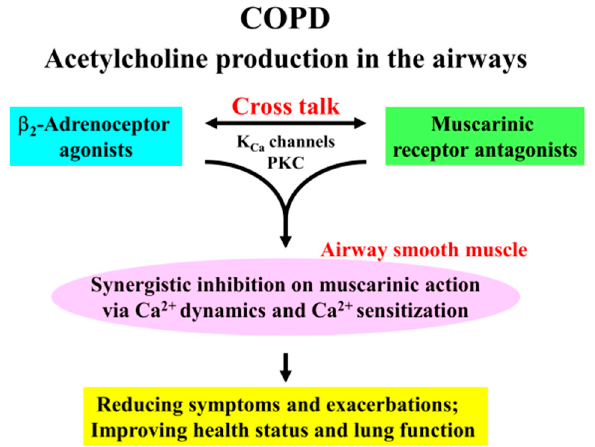
Figure 10. Clinical effectiveness of Combination of β 2 -adrenoceptor agonists and muscarinic receptor antagonists is in the treatment for COPD via Ca 2+ signaling (Ca 2+ dynamics and Ca 2+ sensitization). Since addition of β 2 -adrenoceptor agonists to muscarinic receptor antagonists markedly enhance an inhibition of airway smooth muscle contraction, combination of these two agents are useful to suppression of excessive stimulation to muscarinic receptors induced by acetylcholine production in the airways, which is an fundamental characteristic for COPD. This phenomenon is due to cross talk between these two receptors via K Ca channel-induced Ca 2+ dynamics and PKC-induced Ca 2+ sensitization in airway smooth muscle. Therefore, this combination therapy leads to reducing symptoms such as dyspnea on exertion and frequency of exacerbations, and to improving health status and lung function in patients with COPD.